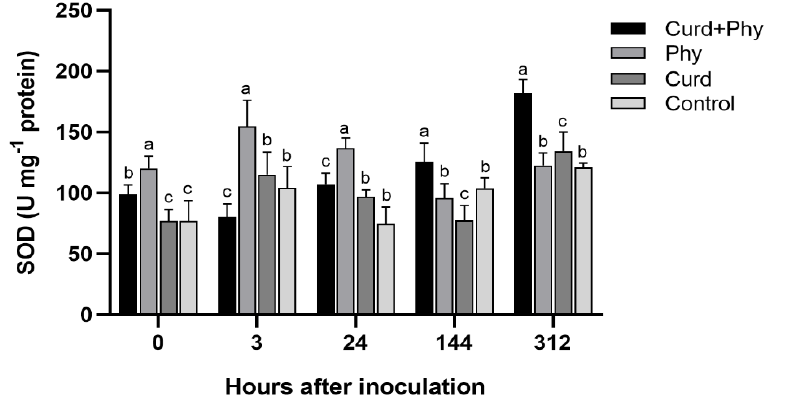
Figure 1. Effect of curdlan treatment on SOD activity from avocado plant leaves inoculated with P. cinnamomi . Curd + Phy, Phy, Curd and Control represent the application of Curd one day before inoculation of P. cinnamomi , inoculation of P. cinnamomi , application of Curd without inoculation of P. cinnamomi and the control (distilled water), respectively. Data are presented as the mean ± standard deviation for nine replicates. Means with the same letter are not significantly different (ANOVA followed by Tukey’s test at p < 0.05).